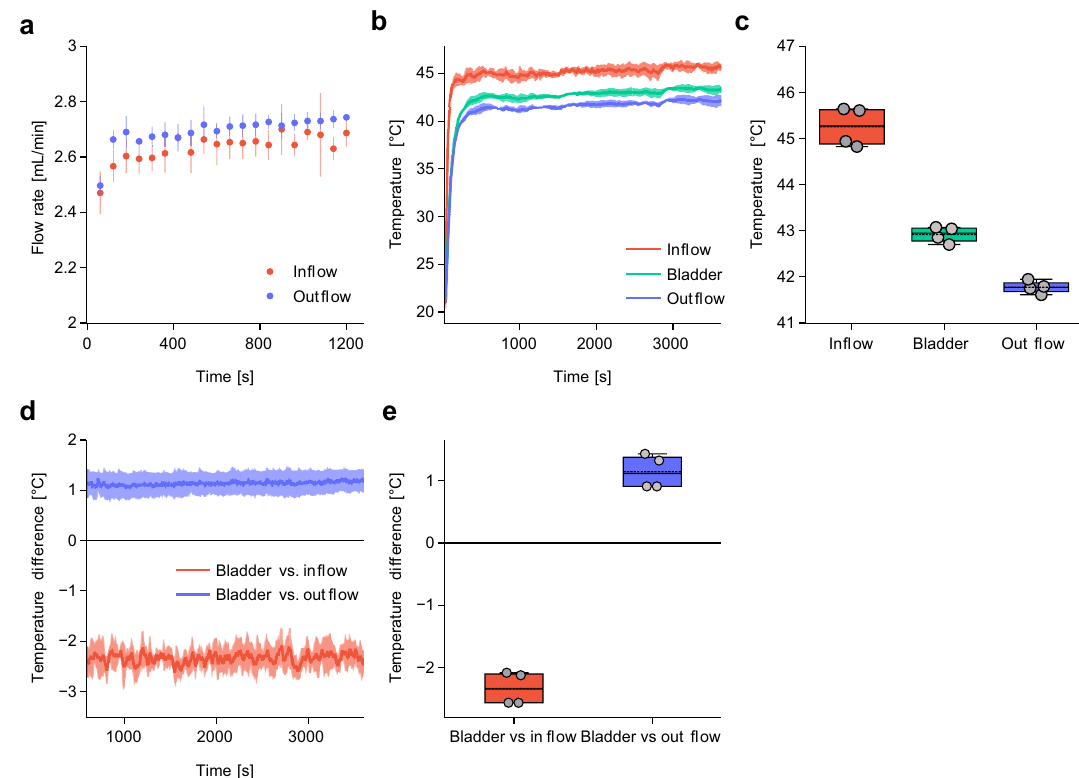
Figure 2. Setup validation using a bladder phantom. ( a ) Flow rates of the inflow and outflow in bladder phantom at fixed pump setting of 2.5 mL/min (n = 3). ( b ) Average temperature kinetics during one hour of HIVEC in the bladder phantom. ( c ) Average temperature during the steady state phase (600–3600 s). ( d ) Temperature difference between the bladder and the inflow/outflow channels during steady-state phase. ( e ) Average temperature difference between the bladder and inflow/outflow channels during steady state phase. All data are mean ± SD. All temperature data were gathered in four independent